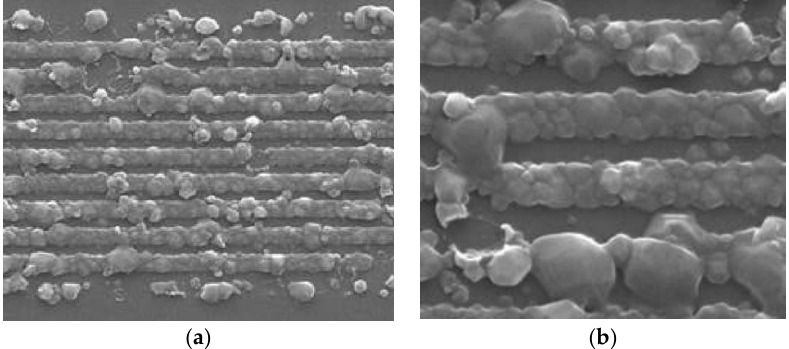
Figure 3. ( a ) SEM picture of a reflector (located on the membrane), after membrane etching and improper IDT and reflector protection; ( b ) zoom on a few fingers.